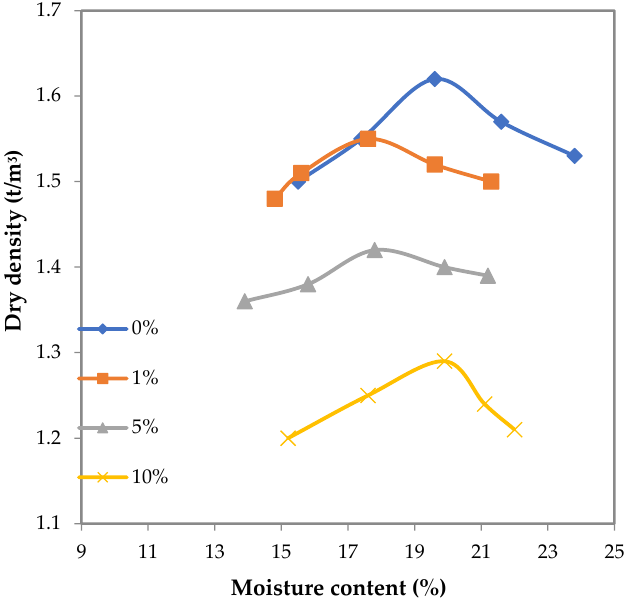
Figure 9. Effect of different Diss fibers ’ content on compaction characteristics.